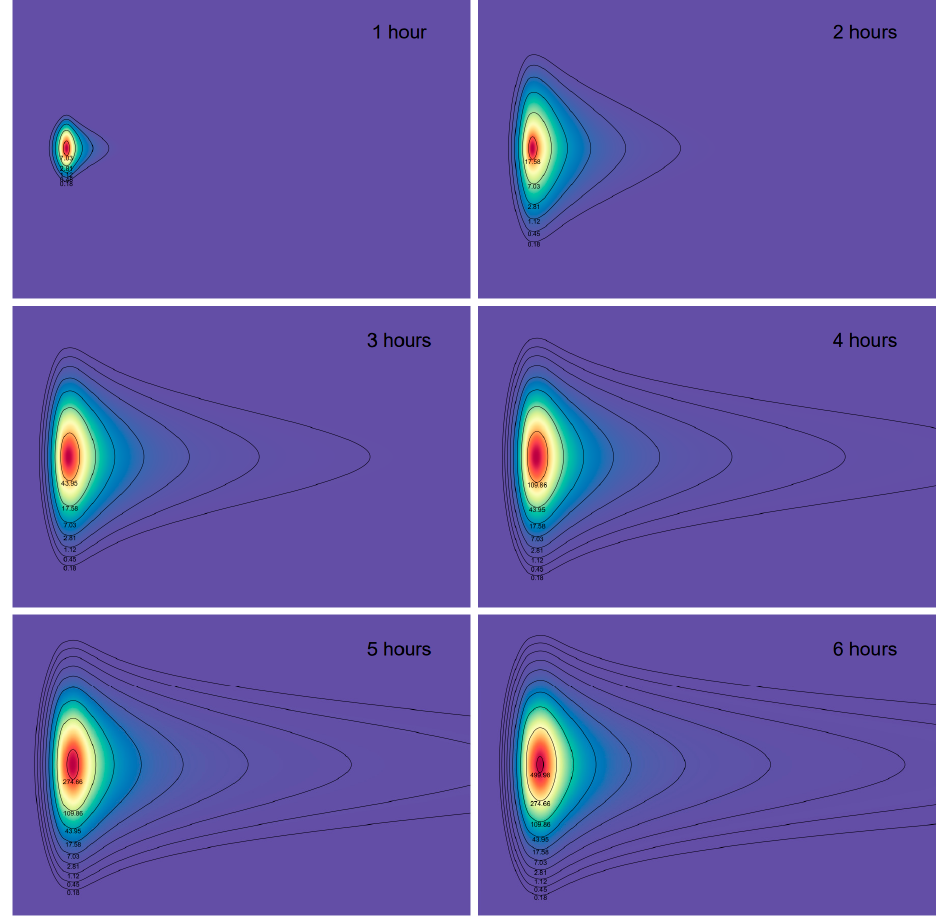
Figure 5. Predicted dose dispersion of radioactive hazardous substances from 1 to 6 h after a nuclear explosion.